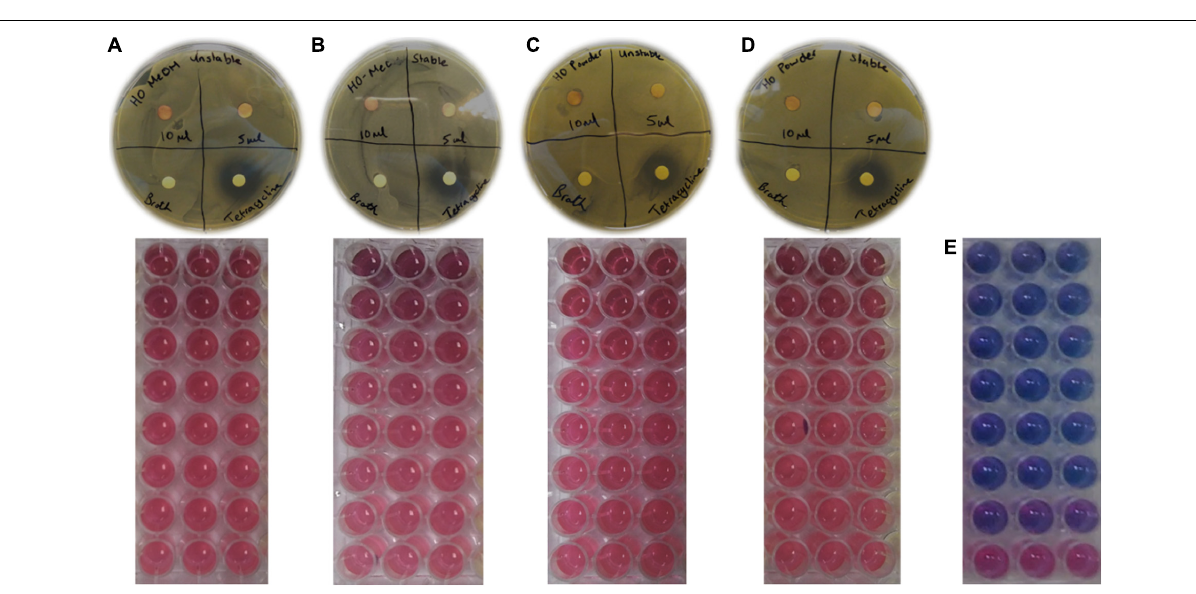
FIGURE 9 | Disc diffusion and microdilution assay plates for (A) Helichrysum odoratissimum methanol extract AuNPs + Gum arabic, (B) H. odoratissimum methanol extract AuNPs – Gum arabic, (C) H. odoratissimum leaf powder AuNPs + Gum arabic, (D) H. odoratissimum leaf powder AuNPs – Gum arabic and (E) Tetracycline against Cutibacterium acnes grown on Brain Heart Infusion agar plates. Pink indicates C. acnes growth and purple/blue indicates bacterial